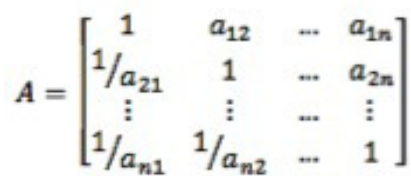
Figure 1 - Judgments Matrix - Gomes et al.